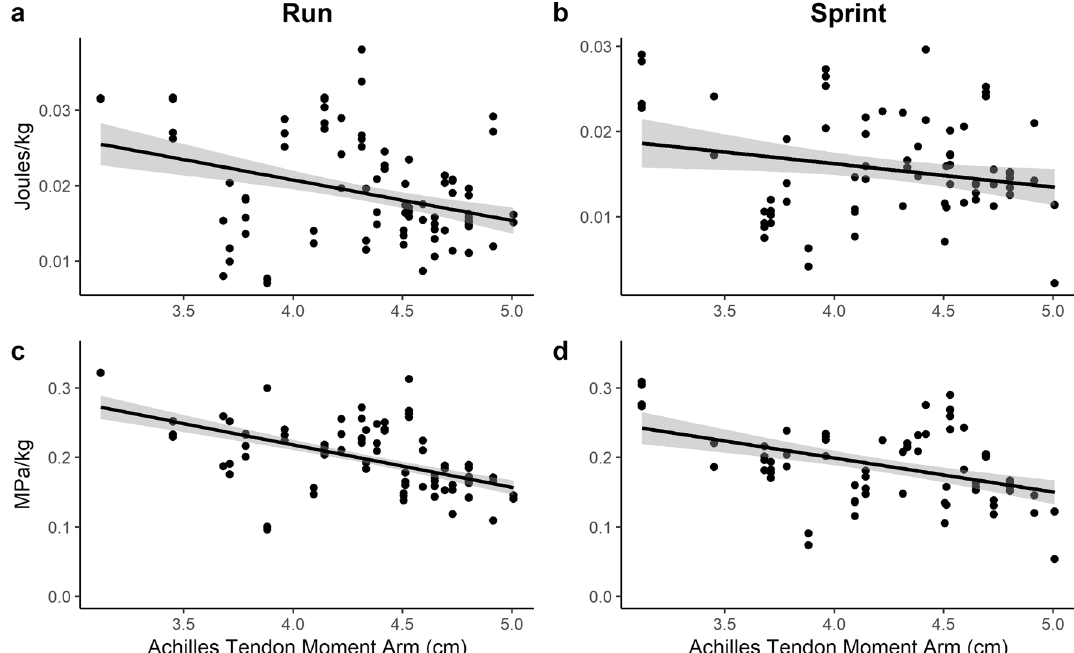
Figure 3. Scatter plots of AT moment arm length and mass-specific tendon stress (MPa/kg) for running ( a ) and sprinting ( b ) trials. Scatter plot of AT moment arm and mass-specific tendon energy storage (Joules/kg) for running ( c ) and sprinting ( d ) trials. The black line is a least squares best fit line and the gray band represents the confidence